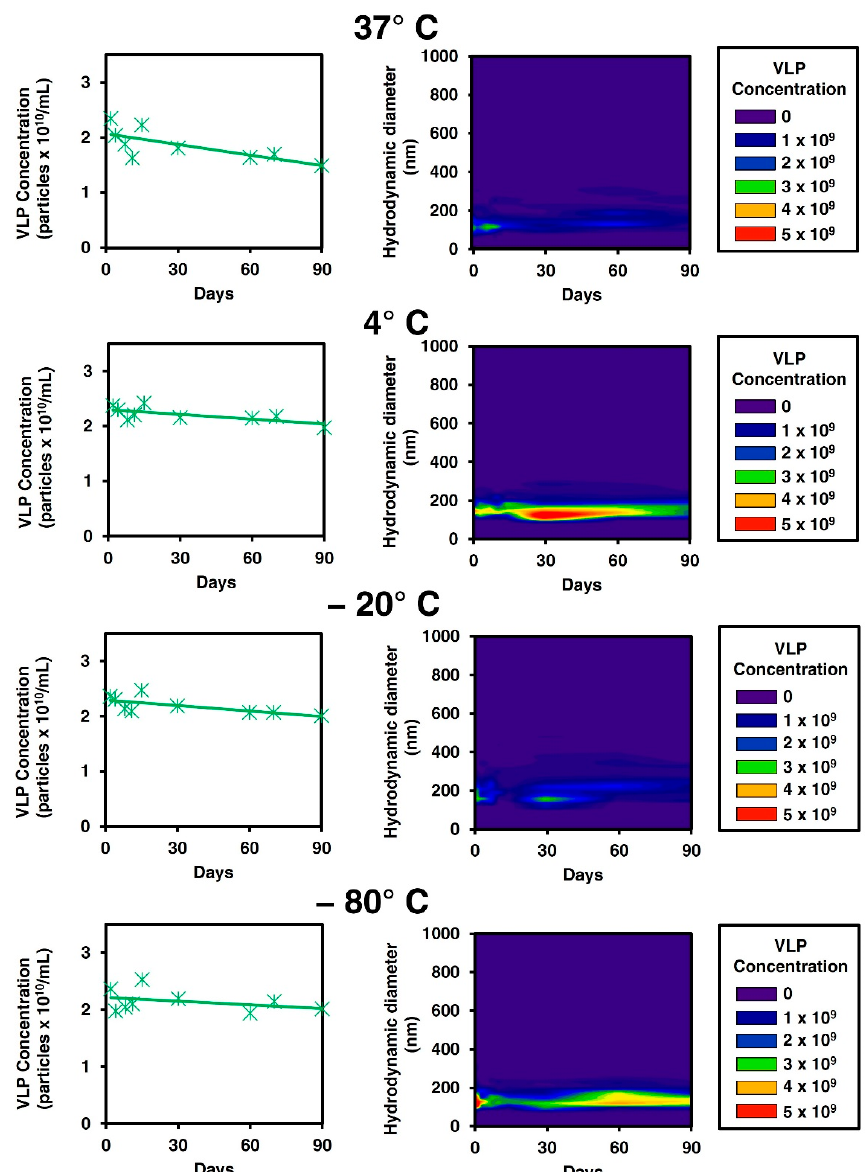
Figure 1. Gag ‐ eGFP VLP thermostability studies. Gag ‐ eGFP VLPs were stored at different temper ‐ atures: 37, 4, − 20, and − 80 °C, respectively. Concentration of Gag ‐ eGFP VLPs was quantified by spectrofluorometry ‐ based assay (line chart), and the particle size distribution (PSD) was analyzed with NTA (contour chart) for the four conditions with